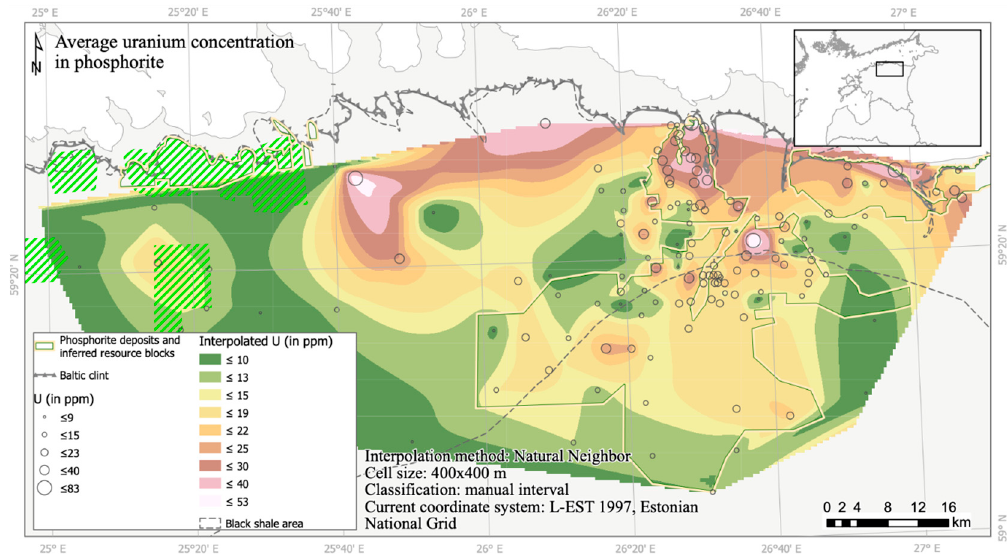
Figure 9. The distribution model of U in the main phosphorite deposit areas based on the historical data.